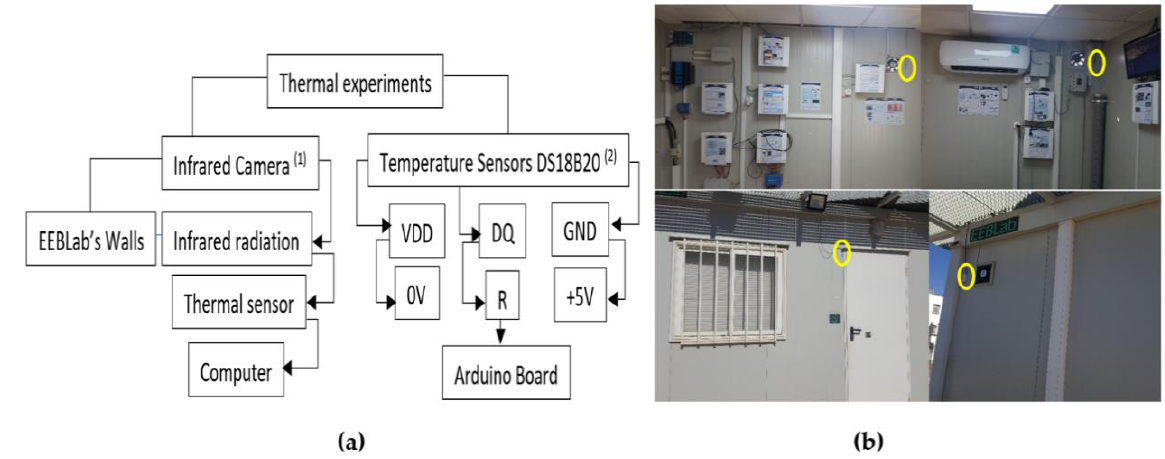
Figure 11. Experimental Set-Up ( a ) Thermal equipment ( b ) Some examples of numerical sensors placement.